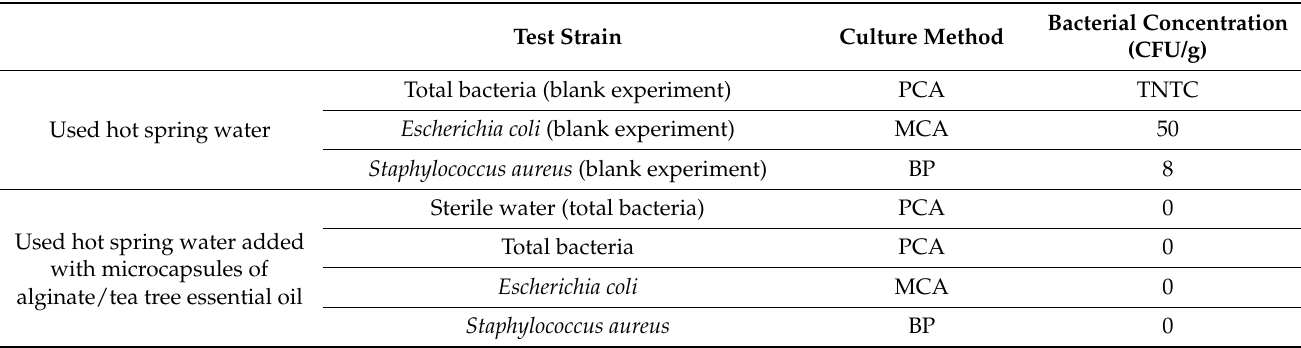
Table 7. The antibacterial effect of used hot spring water by the microcapsules of alginate/tea tree essential oil. Test Strain Culture Method